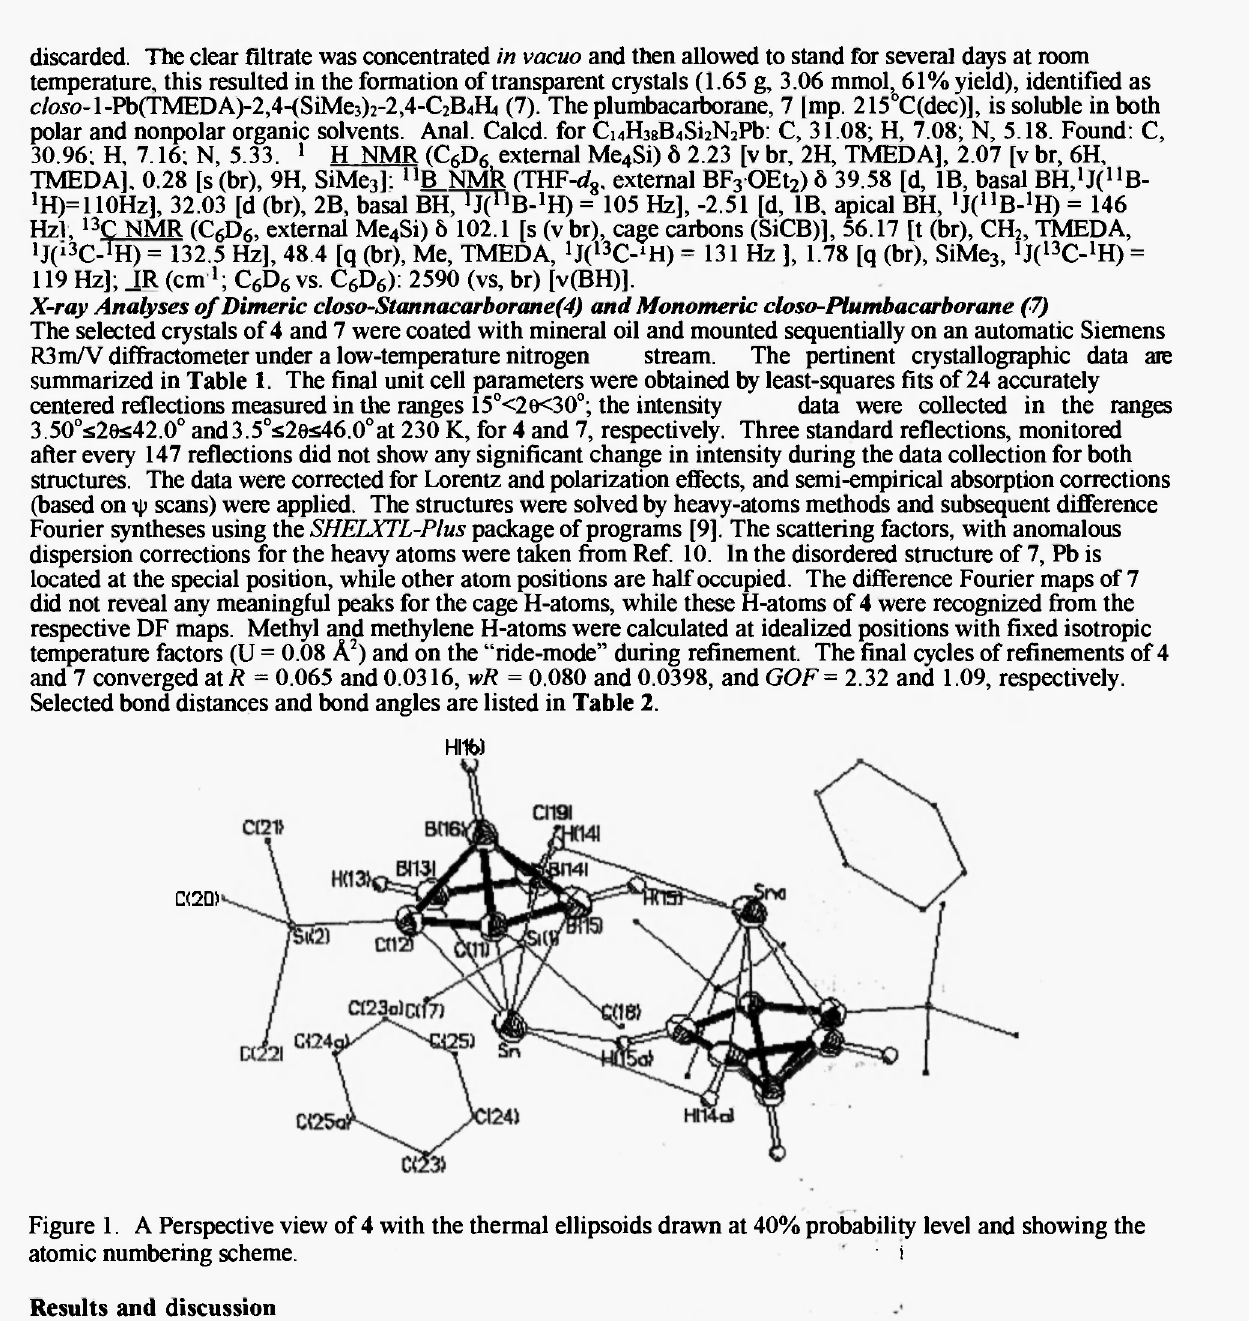
Figure 1. A Perspective view of 4 with the thermal ellipsoids drawn at 40% probability level and showing the Results and